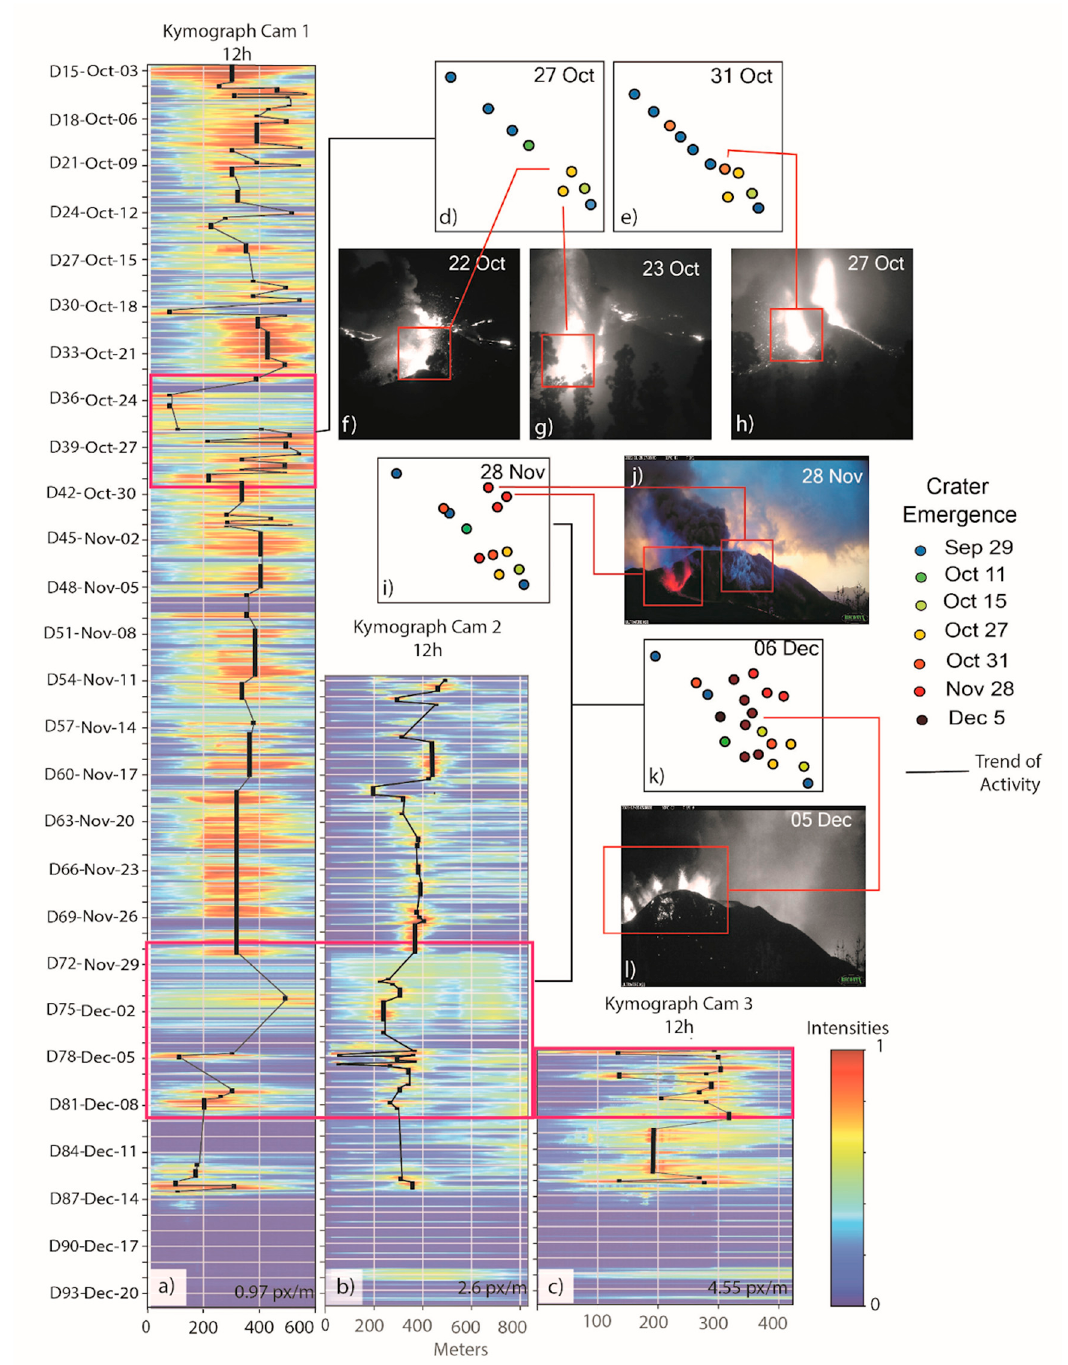
Figure 5. Kymographs of ( a ) Camera 1, ( b ) Camera 2, and ( c ) Camera 3 show a space vs. time plot, where the horizontal axis shows the pixel intensities extracted along the profile, and the y-axis corresponds to the time when the photographs were taken. The intensity scale is a value normalized from 0 to 1, where warmer colors represent lava fountains shown by brighter pixels. The red boxes highlight periods of fluctuations that coincide with the transition of the phases. ( d , e ) Craters identified in SAR amplitude image from 27 to 31 October 2021, respectively. ( f – h ) Time-lapse Camera 1 image on the nights of 22, 23, and 27 October 2021. ( i ) Crater identified in SAR amplitude image from 28 November. ( j ) Time-lapse Camera 2 image on the night of 28 November 2021 ( k ) Crater identified in SAR image from 6 December 2021. ( l ) Camera 3 image on the night of 5 December 2021.